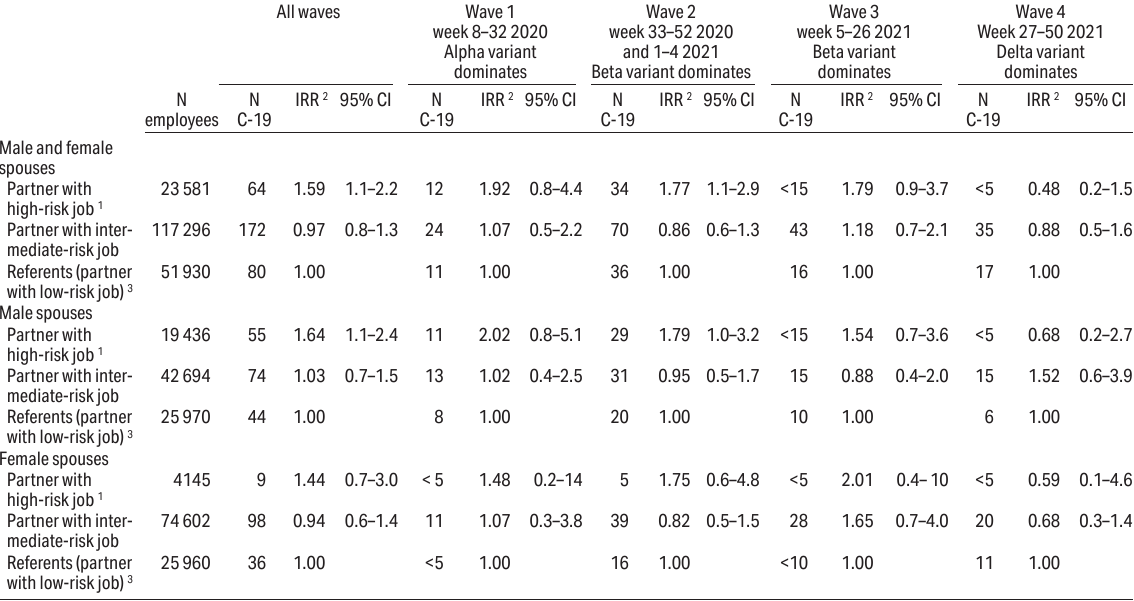
Table 2. Incidence rate ratios (IRR) with 95% confidence intervals (CI) for COVID-19 (C-19)-related hospital admission in spouses of partners with intermediate- and high-risk jobs